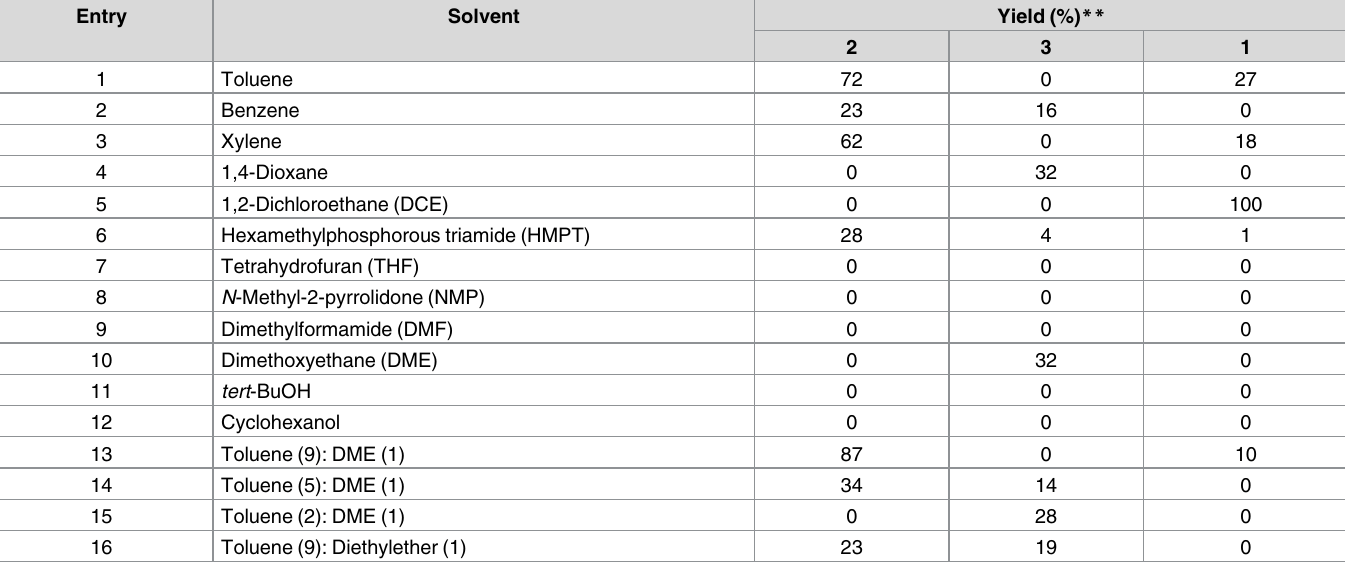
Table 4. Effect of the solvent. *